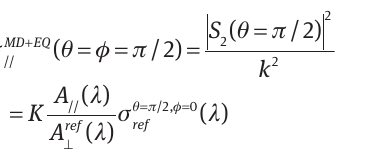
Figure 6: Plots of the experimental function A of the ratio of the magnetic to electric dipolar scattering. Dashed and solid lines correspond to light scattering measurements before and after condensation, respectively. The ratio increases with gold load and with condensation, well above values observed on gold raspberries shown for comparison (squares; from Ref.